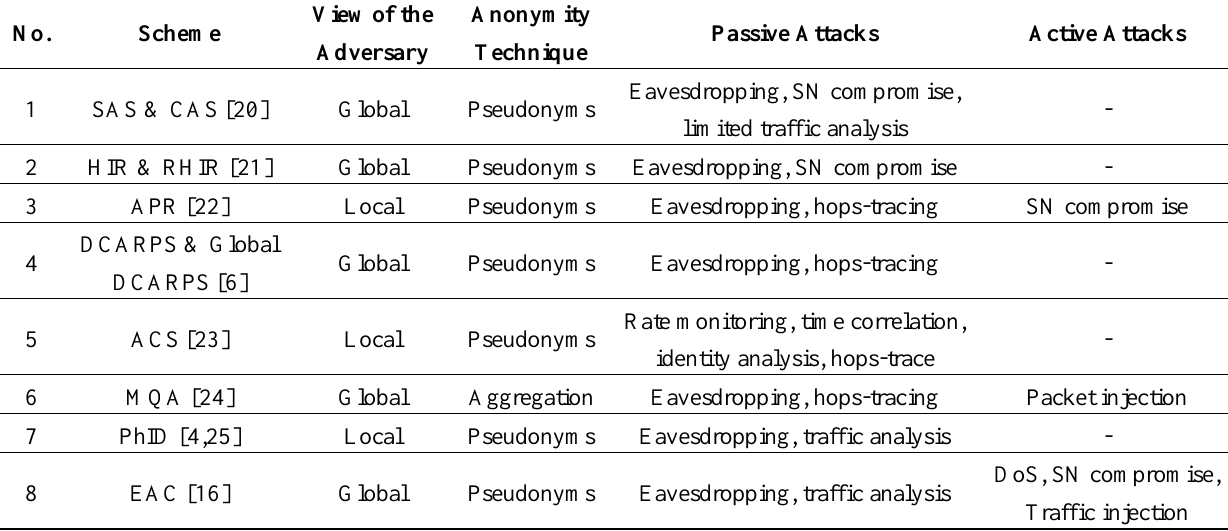
Table 1. Solutions for location privacy using anonymity [4]. SAS, Simple Anonymity Scheme; CAS, Cryptographic Anonymity Scheme; HIR, Hashing-Based ID Randomization; RHIR, Reverse HIR; APR, Anonymous Path Routing; ACS, Anonymous Communications Scheme; DCARPS, Destination Controlled Anonymous Routing Protocol for Sensor Nets; MAQ, Max Query Aggregation; PhID, Phantom ID; EAC, Efficient Anonymous